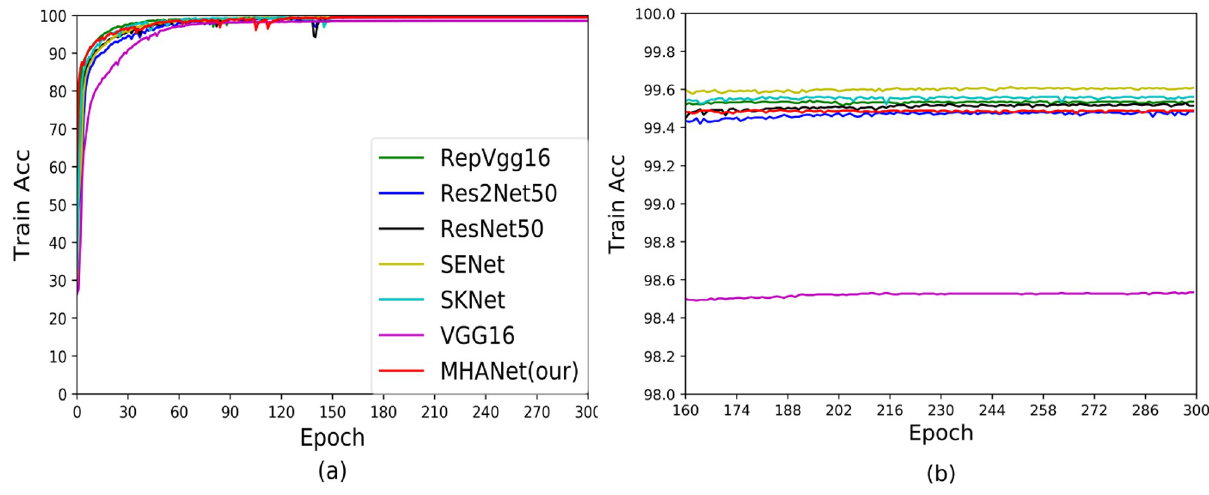
Fig 7. Training accuracy curves of Dataset2.